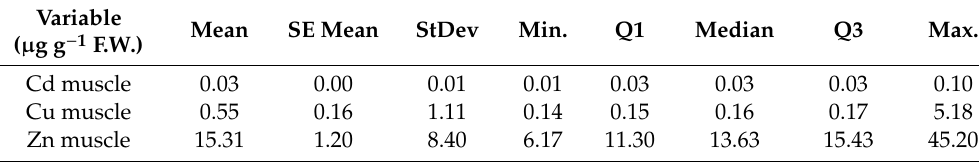
Table A5. Descriptive statistics of third group